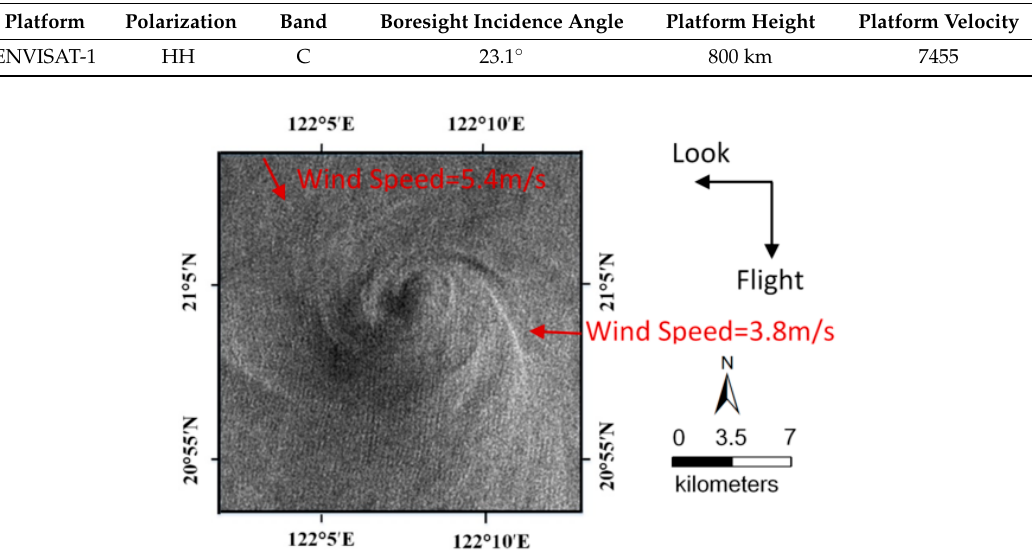
Figure 6. Enlargement of the shear-wave-generated eddy in Frame A. The flight and look direction of ENVISAT-1 ASAR are indicated by black arrows. Two wind vectors are shown as red arrows. In Figure 6, the flight and look direction of ENVISAT-1 ASAR are indicated by black arrows. Two wind vectors were identified and shown as red arrows. The sea surface wind data was obtained from QuikSCAT on 27 April 2005 [27]. The grid resolution of the wind field is 25 km × 25 km over